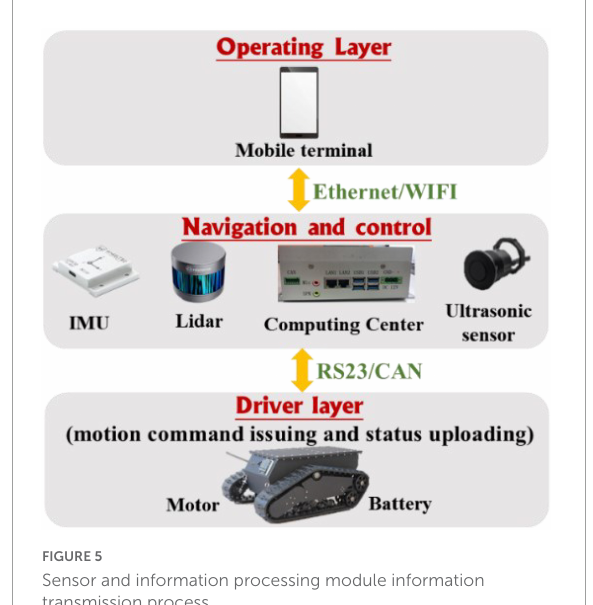
FIGURE5 Sensor and information processing module information transmission process.